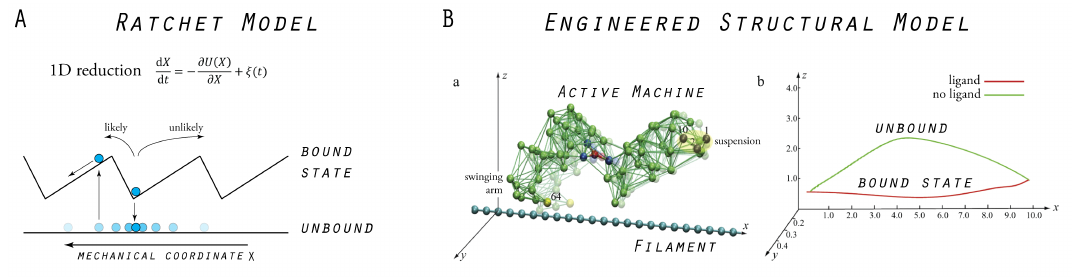
Figure 3. Models of molecular motors: ( A ) Traditional ratchet model in which the motor dynamics is drastically reduced to the problem of a point-like particle moving in a one-dimensional sawtooth potential, or being exposed to diffusion in its absence, respectively. ( B ) Our model molecular motor, consisting of the designed elastic network machine and a rod-like filament. In the presence of a ligand, the machine moves near the filament (and can bind to it), while, after ligand removal, it moves farther away (and is unbound from the filament), as illustrated by the trace of the motor’s swinging arm relative to the filament axis (right figure). Ratcheting transport is thus naturally implemented. Images in ( B ) are adapted from Reference [22] (slightly